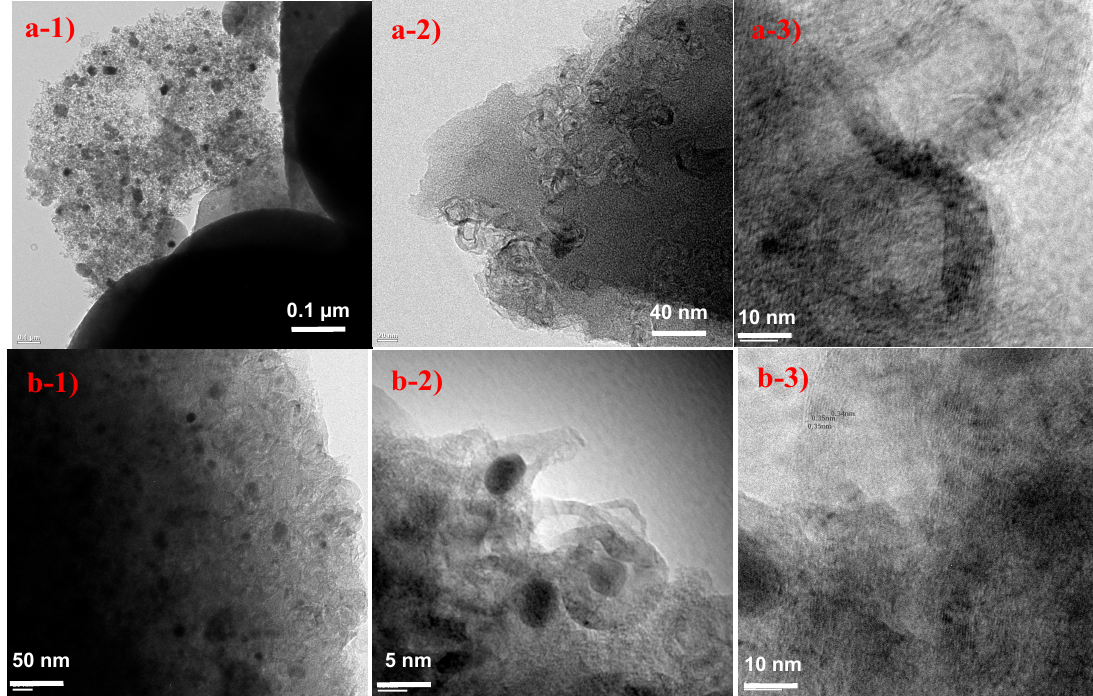
Figure 11. TEM pictures of ( a ) iron/carbon hybrid material loaded with 2% of Fe 2+ , based on tannin-derived hydrothermal carbon prepared at 180 °C and pyrolysed at 900 °C, at different magnifications, showing iron nanoparticles and graphite-like capsules; ( b ) same as ( a ) but the material was loaded with 20% of iron.